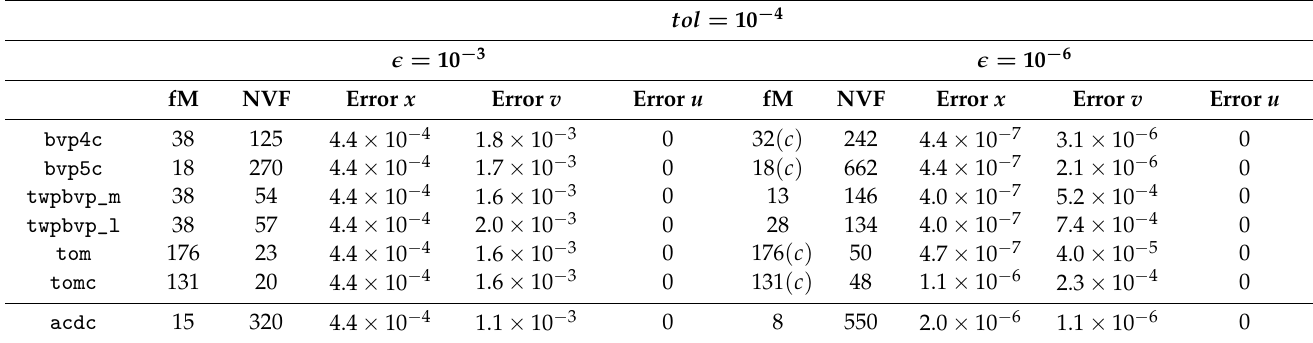
Table 16. Longitudinal dynamics of a vehicle T = 10, g = 9.81, k 0 = 0.02 g , k 1 = 10 − 5 g , k 2 = 0, k 3 = 0: final mesh (fM), total number of vectorized function evaluation (NVF) and mixed errors for x , v , u .